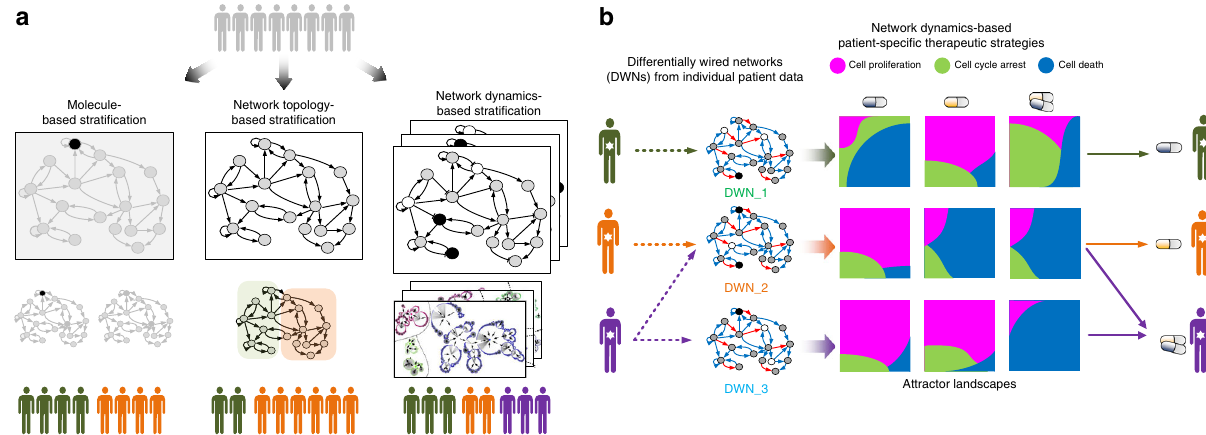
Fig. 6 Network dynamics-based therapy. a Various approaches to stratify cancer patients based on their genomic pro fi les. b The work fl ow of employing network dynamics-based analysis to design patient-speci fi c therapeutic